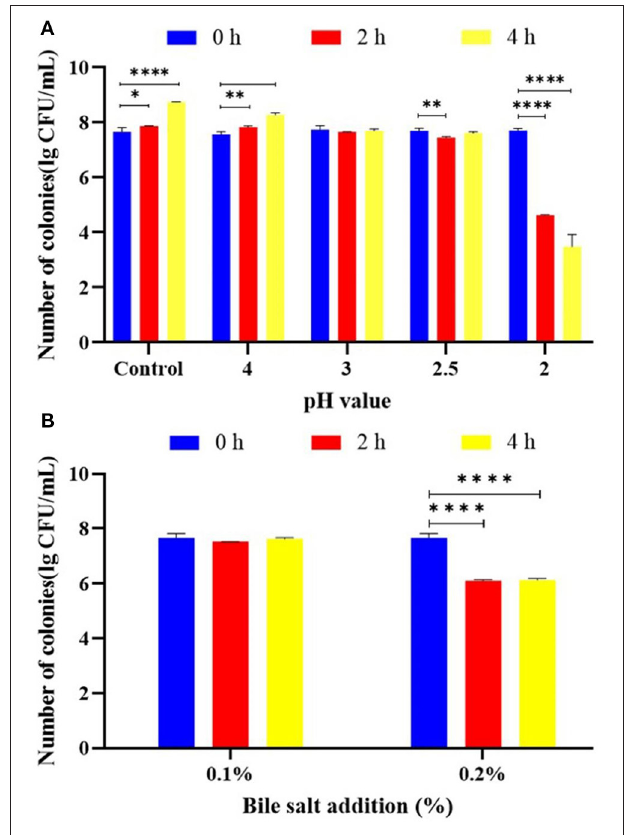
FIGURE 2 | Probiotic properties of L. plantarum KM1. The acid tolerance (A) and bile salt tolerance (B) of L. plantarum KM1. * p < 0.05, ** p < 0.01, and **** p < 0.0001.